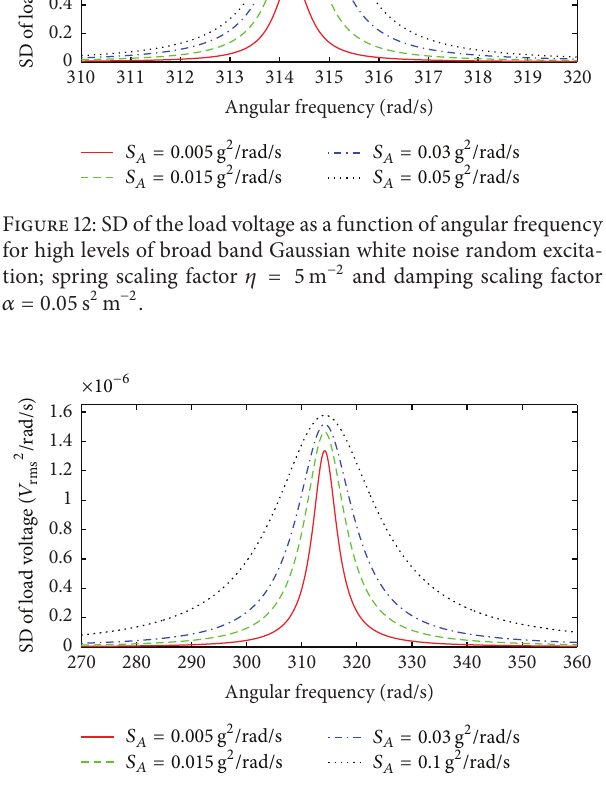
Figure 13: SD of the load voltage as a function of angular frequency for high levels of broad band Gaussian white random excitation; spring scaling factor 𝜂 = 5 m −2 and damping scaling factor 𝛼 = 5 s 2 m −2 .